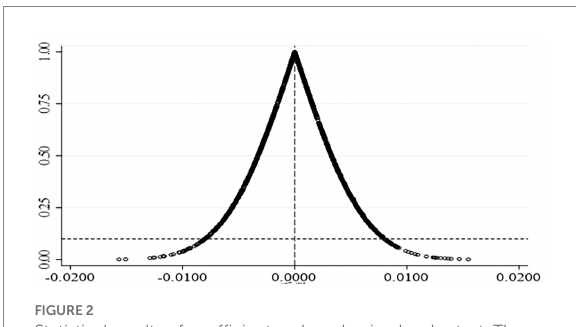
FIGURE 2 Statistical results of coefficient and p value in placebo test. The horizontal axis represents the coefficient and the vertical axis represents the value of p .